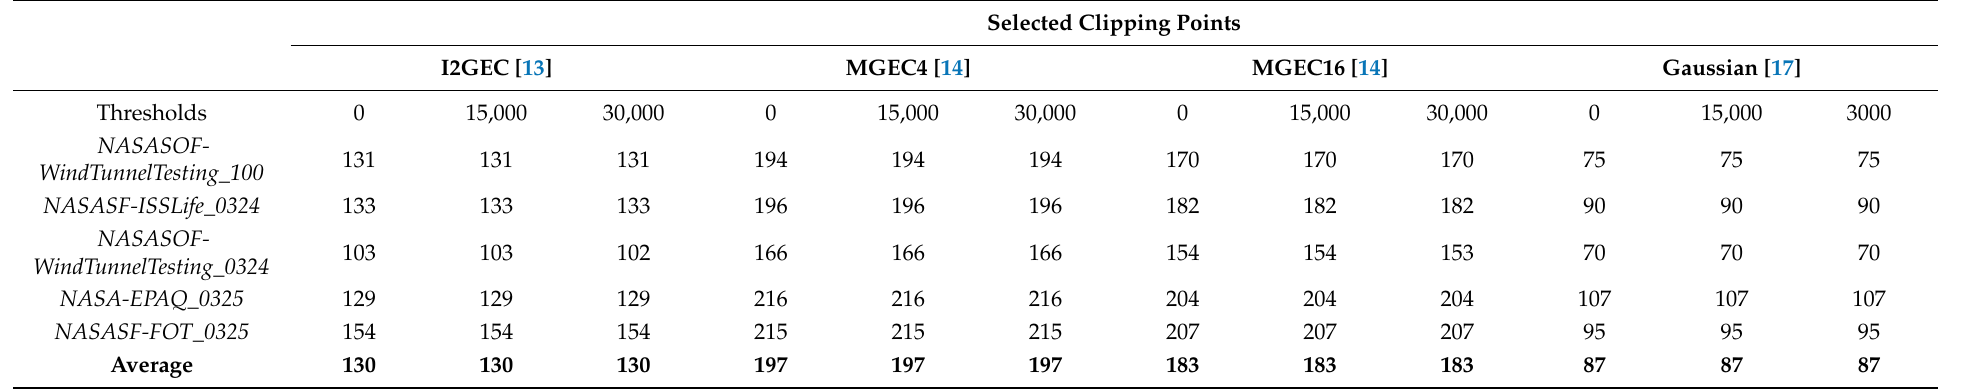
Table A4. Selected clipping points (in unit of grey scale pixel) of different algorithms at different